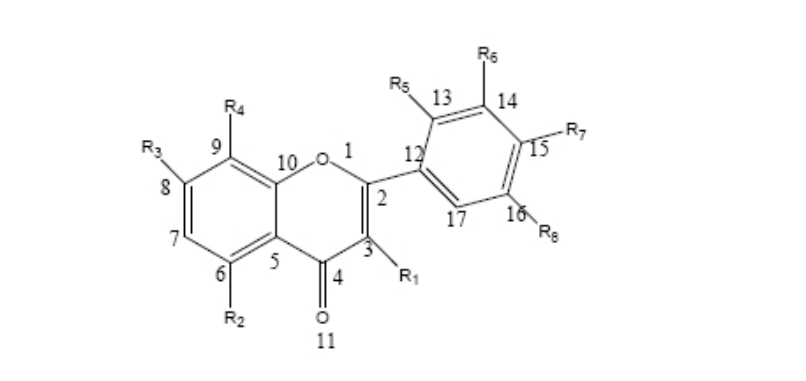
Fig. 1 General structure of flavonoids: the common atoms have been numbered